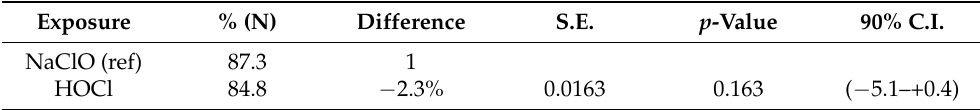
Table 3. Results from linear regression with week and cluster as fixed effects.